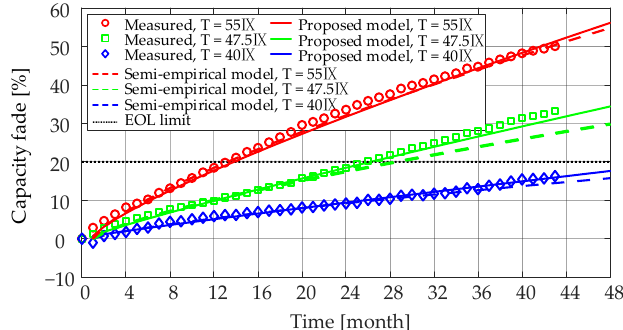
Figure 21. Comparison of modeling results for temperature dependence of capacity fade (at 50% SOC level). Table 7. Comparison of the lifetime prediction results between the proposed capacity fade model and the semi-empirical model (Only the effects of storage time and temperature are considered; when 20% capacity fade EOL criterion has been reached, SOC level is fixed to 50%).